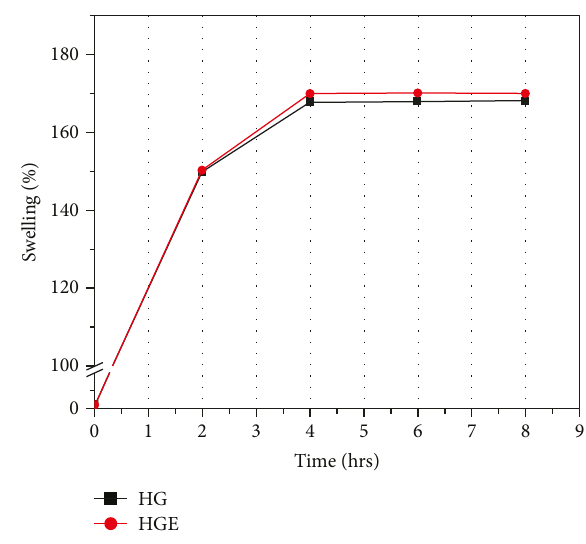
Figure 5: Swelling behavior of the prepared hydrogels over a period of 8